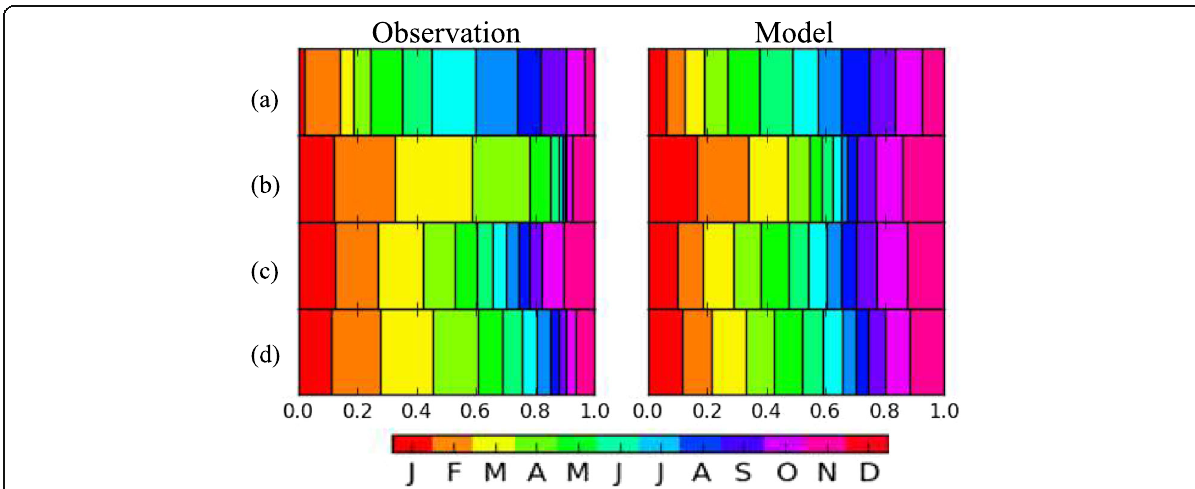
Fig. 3 Monthly breakdown of annual suspended sediment flow. a Serrinha, b Porto Velho, c Manacapuru, d Obidos. Left column indicates observation, right column indicates CTL